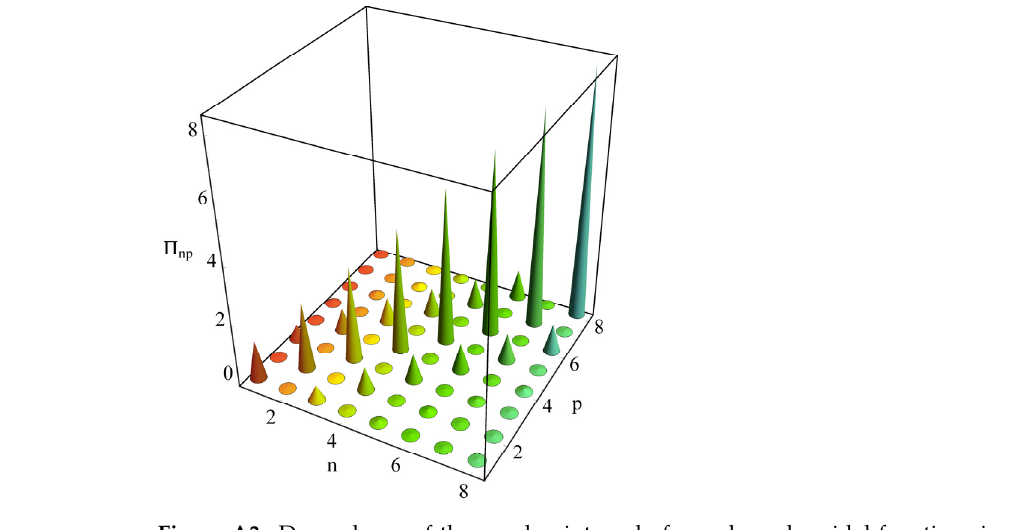
Figure A3. Dependence of the overlap integral of angular spheroidal functions in an elongated spheroid ∏ n,p ( c 1 ,c 0 ) on indices. c 1 = 4, c 0 = c 1 / ε =0.5657, ε = 50.